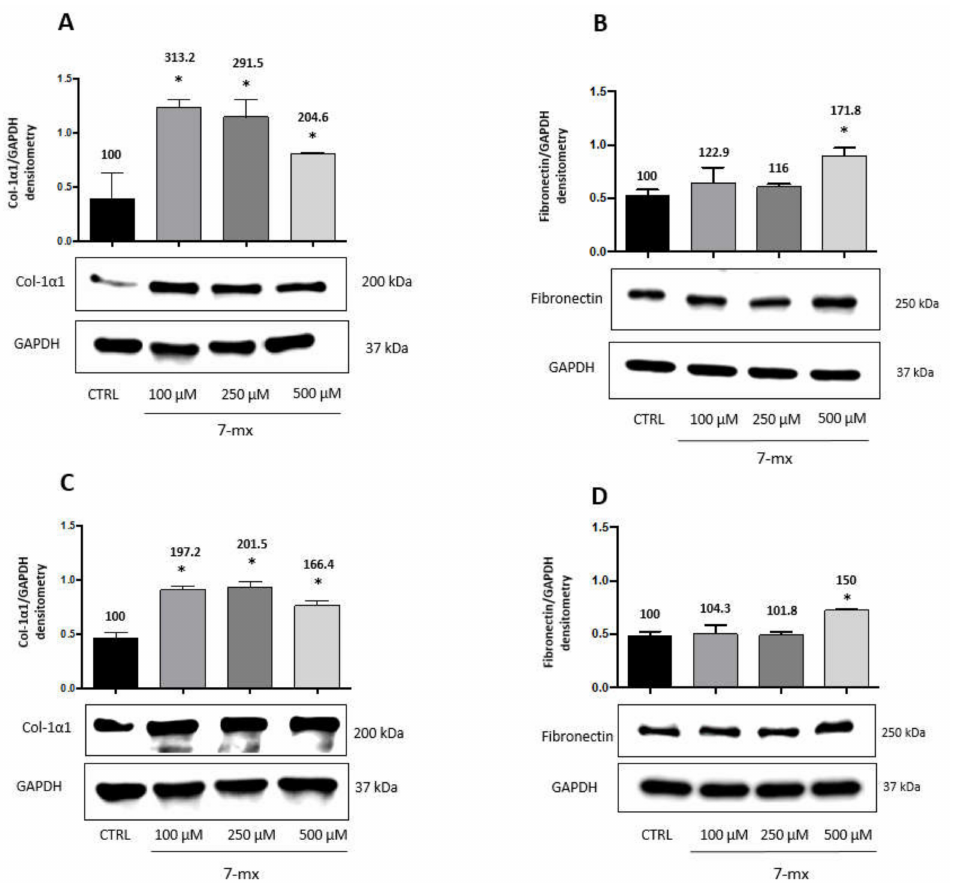
Figure 2. 7MX e ff ects on collagen and fibronectin production by HSF cells. Western immunoblot analysis of collagen type-1 α 1 (Col-1 α 1) and fibronectin in HSF lysates treated with 7MX at di ff erent doses as indicated for 24 and 48 h. A representative Western immunoblot is shown at the bottom of each panel, and the quantitative analysis is reported in the histogram above. Numbers on bars indicate the percentage value with respect to the control, set at 100%. Each bar represents the average value ± SD of three di ff erent experiments: ( A ) Col-1 α 1 24 h; ( B ) Fibronectin 24 h; ( C ) Col-1 α 1 48 h; and ( D ) fibronectin 48 h. * p < 0.05 vs. CTRL. One-way ANOVA, followed by Tukey’s